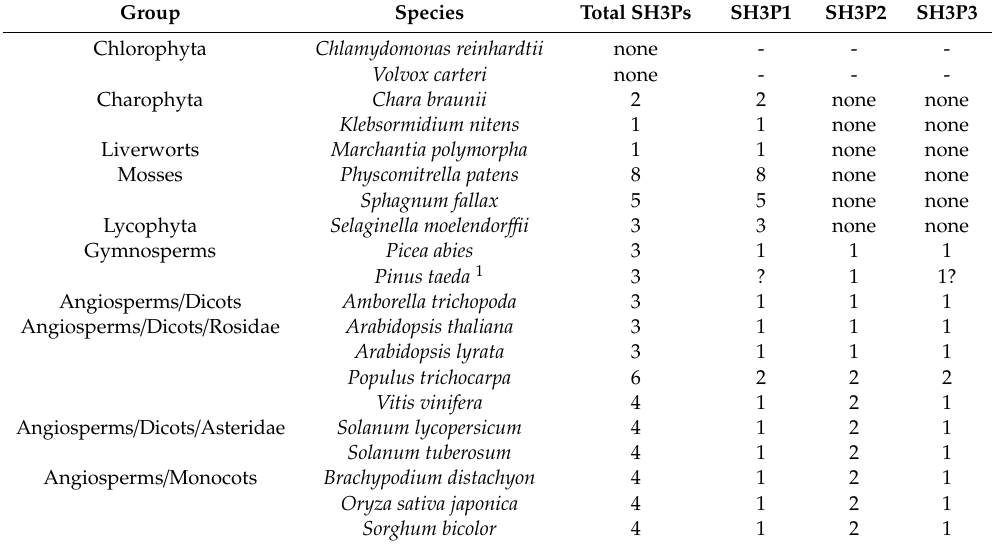
Table 1. Numbers of identified SH3P paralogs in selected plant species. The inventory may still be incomplete for some, in particular non-model,